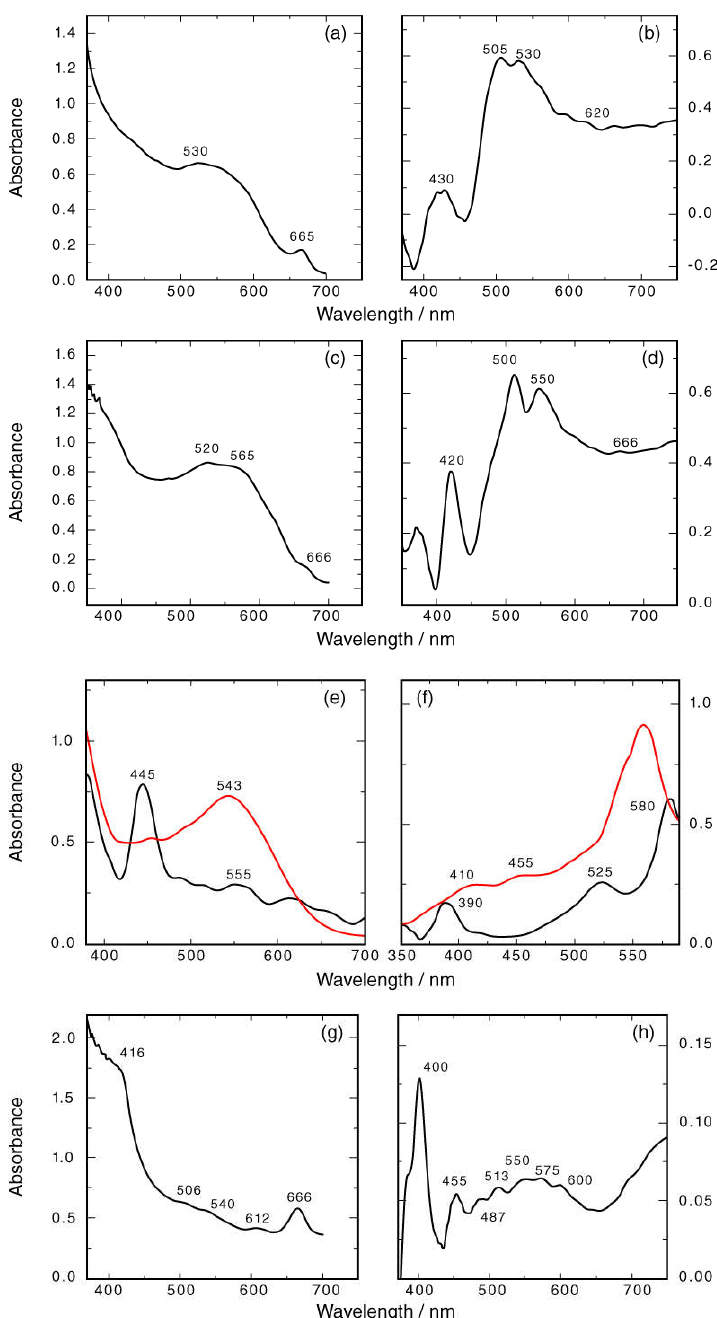
Figure 2. UV-visible spectra for the pigments containing solutions (left side) and adsorbed dyes onto the TiO 2 surface (right side). ( a ) Cyanidin-3-glucoside solution and ( b ) co-adsorbed cyanidin-3-glucoside in the presence of silver NPs. ( c ) Delphinidin-3-glucoside solution and ( d ) co-adsorbed delphinidin-3-glucoside in the presence of silver NPs. ( e ) Delphinidin-3-glucoside (red line) and Cr (III) complex (black line) solutions and ( f ) both species co-adsorbed onto the TiO 2 surface. ( g ) Fucoxanthin solution and ( h ) co-adsorbed fucoxanthin in the presence of silver NPs. The presence of chlorophyll was also detected in the case of fucoxanthin. Still, in